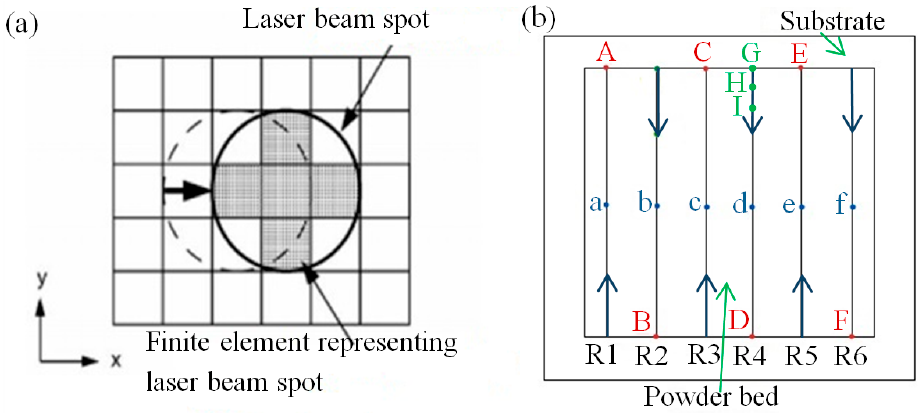
Figure 1. Movement of the laser beam spot and schematic diagram of powder bed. ( a ) Movement of laser beam spot by five elements; ( b ) Scanning strategy.